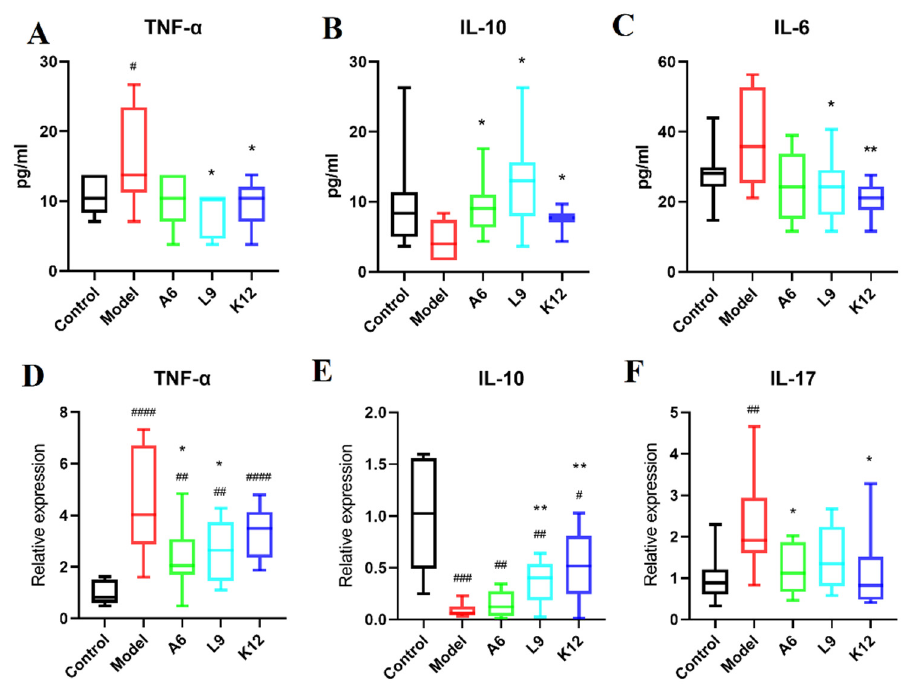
Figure 3. Reduced pro-inflammatory and enhanced anti-inflammatory cytokine expression in A6 or L9 intervention group. ( A – C ) TNF- α , IL-10, and IL-6 expression in serum as detected by ELISA. ( D – F ) Relative expression of TNF- α , IL-10, and IL-17 mRNAs in tissues as determined by RT-PCR. Values designated with a superscript * reflect comparisons with the model group, and values with a # are in relation to the control group ( * p and # p < 0.05; ** p and ## p < 0.01; ### p < 0.001; #### p < 0.0001).